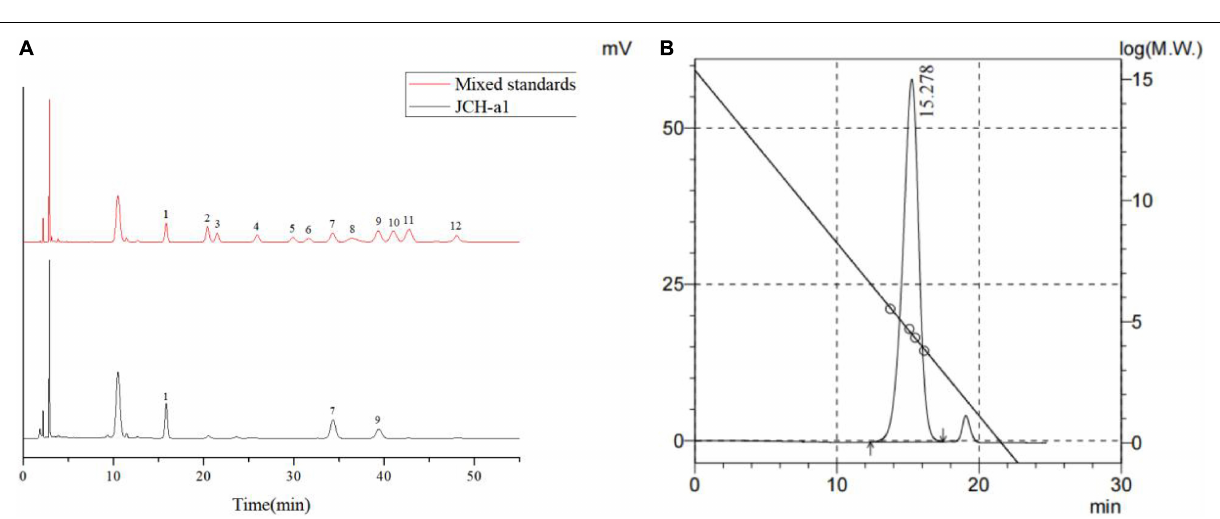
FIGURE 3 | (A) HPLC chromatogram of the monosaccharide standards and JCH-a1. Peaks: 1 Mannose, 2 Ribose, 3 Rhamnose, 4 Glucuronic acid, 5 Galacturonic acid, 6 N- acetyl-glucosamine, 7 Glucose, 8 N- acetyl-galactose, 9 Galactose, 10 Xylose, 11 Arabinose, 12 Fucose; (B) GPC of